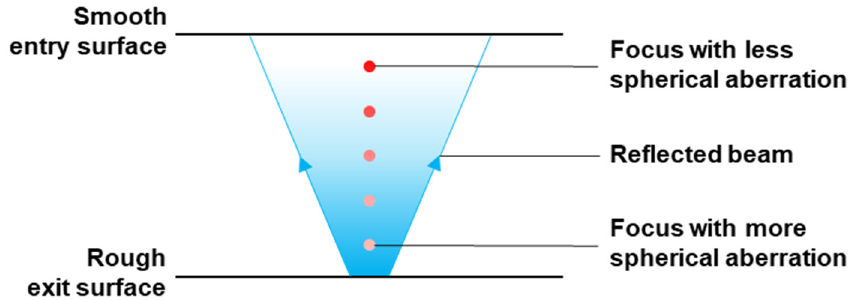
Figure 7. Interaction between the reflected beam and multi-foci with spherical aberration.